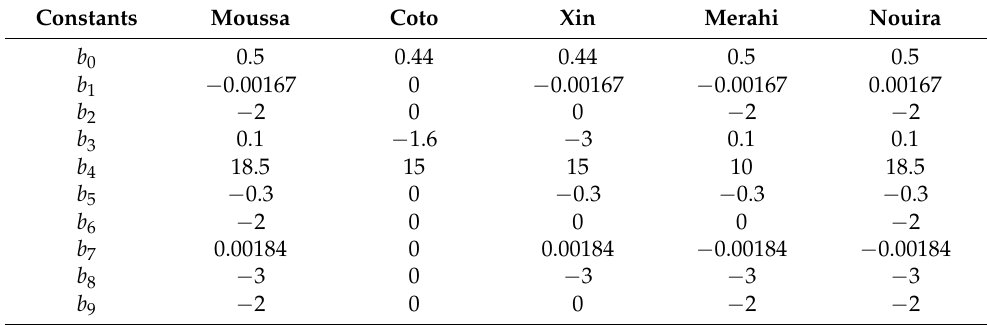
Table 2. Constants of the power coefficients found in relation to the general sinusoidal function. Constants Moussa